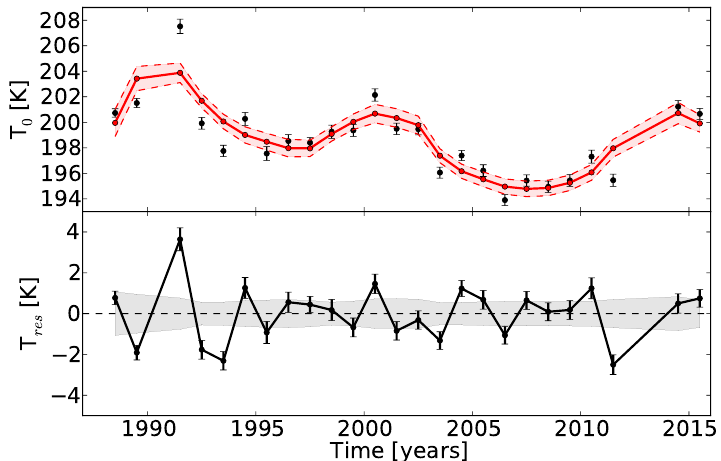
Figure 12. The upper panel of the figure shows the time series of annual average OH ∗ temperatures in black and the fit corresponding to Eq. (10) with the coefficients C solar = (4.1 ± 0.8)K ( 100SFU ) − 1 , C sin = (1.95 ± 0.44)K, and P = (24.8 ± 2.1)years in red. In the lower panel the residual T res of the two is shown. For description of displayed uncertainties see Fig. 6